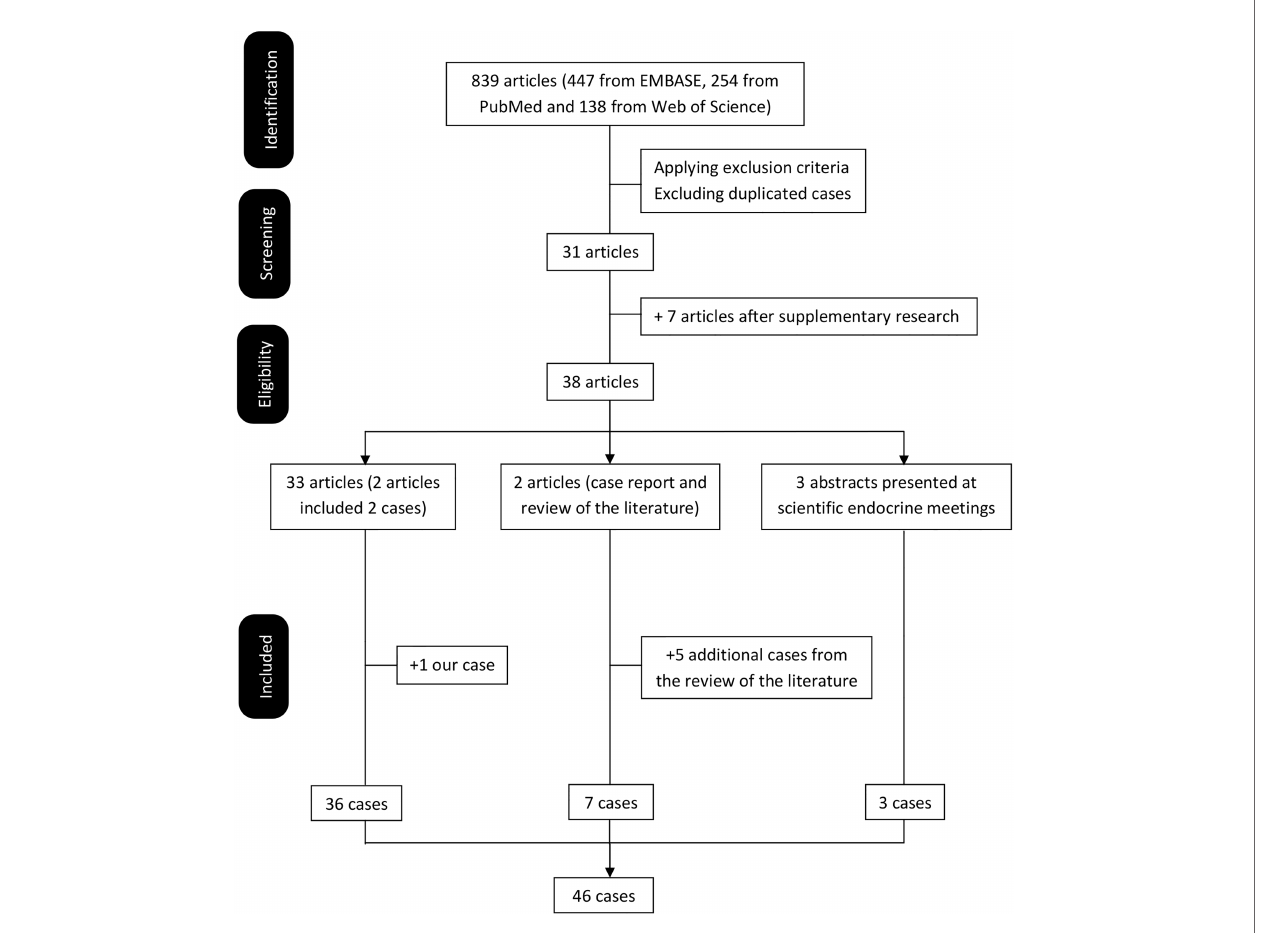
FIGURE 5 | Flowchart of the literature